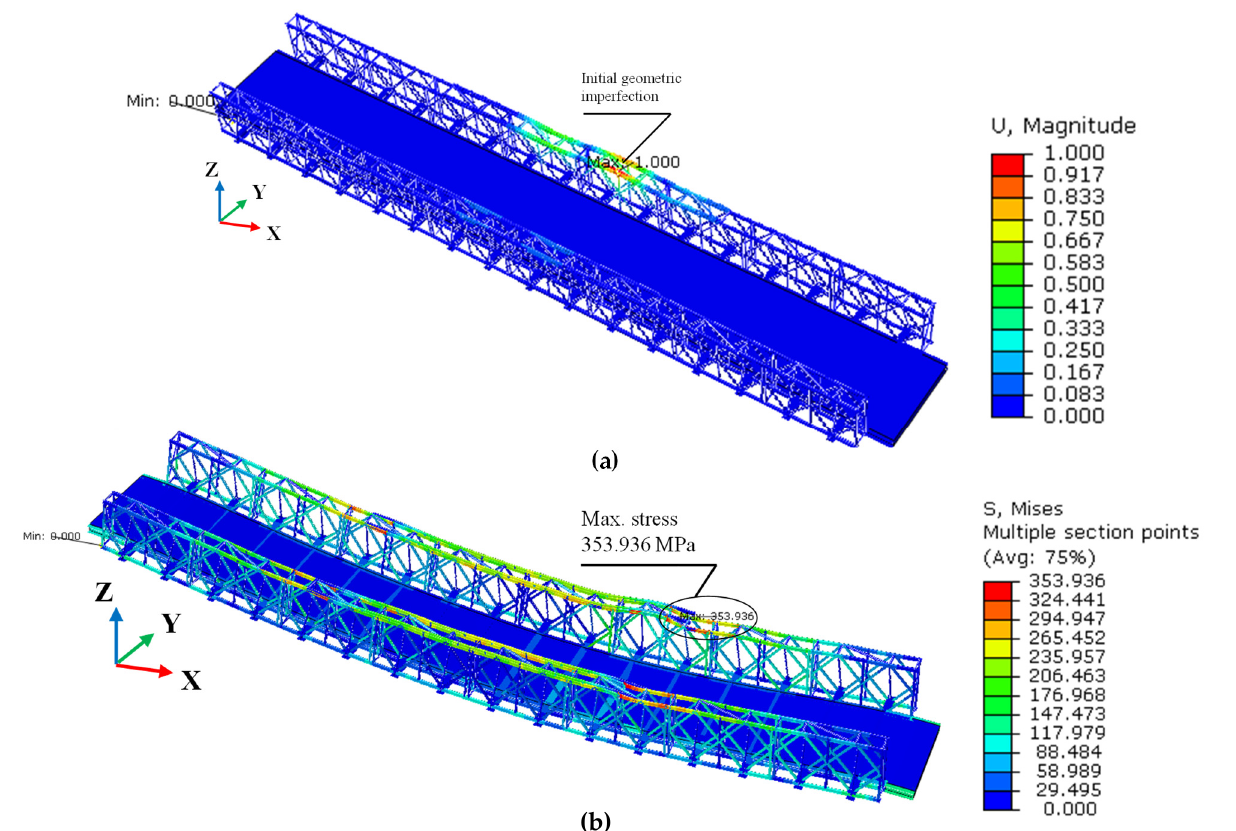
Figure 14 . Results of linear and nonlinear buckling analysis ( a ) Location of local buckling mode 1 ( b ) Location of maximum stress generation.